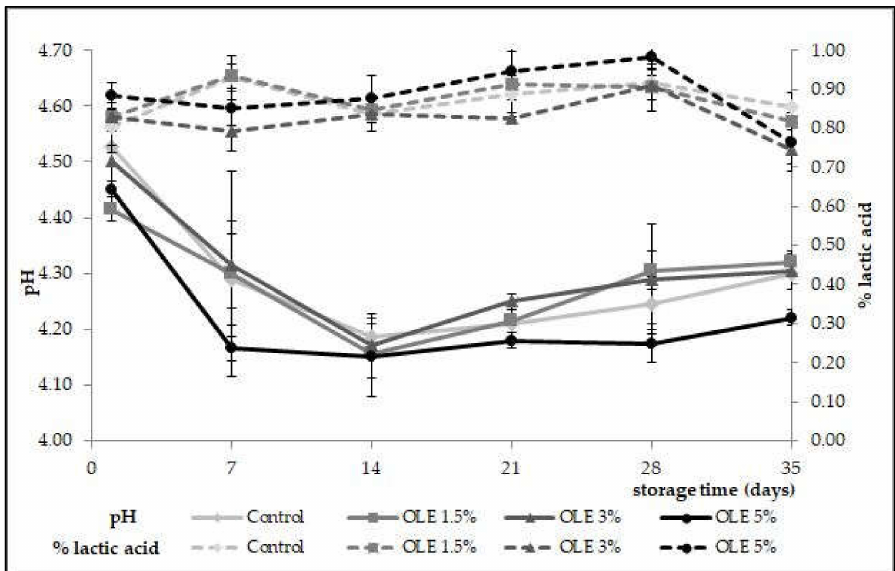
Figure 1. Changes in pH values and titratable acidity (% lactic acid) in yoghurt samples without (control) and with olive leaf extract addition (OLE 1.5%, OLE 3%, and OLE 5%) during 35 days of cold